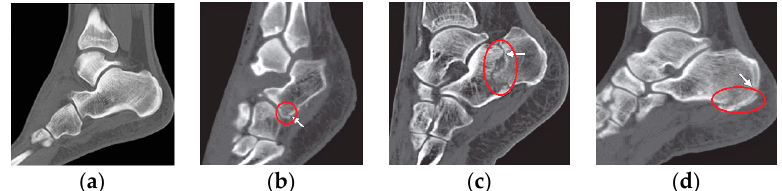
Figure 2. Classification of calcaneus fractures in sagittal images [1,8,10]: ( a ) Normal calcaneus; ( b ) Type A; ( c ) Type B; and ( d ) Type C.